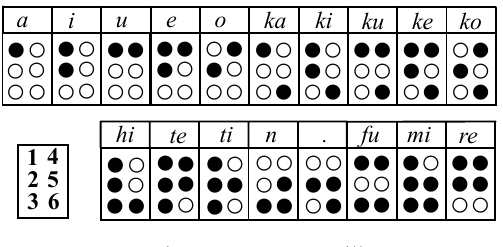
Fig.12 Vibration Actuator Driving of Three-stage mode / ke /